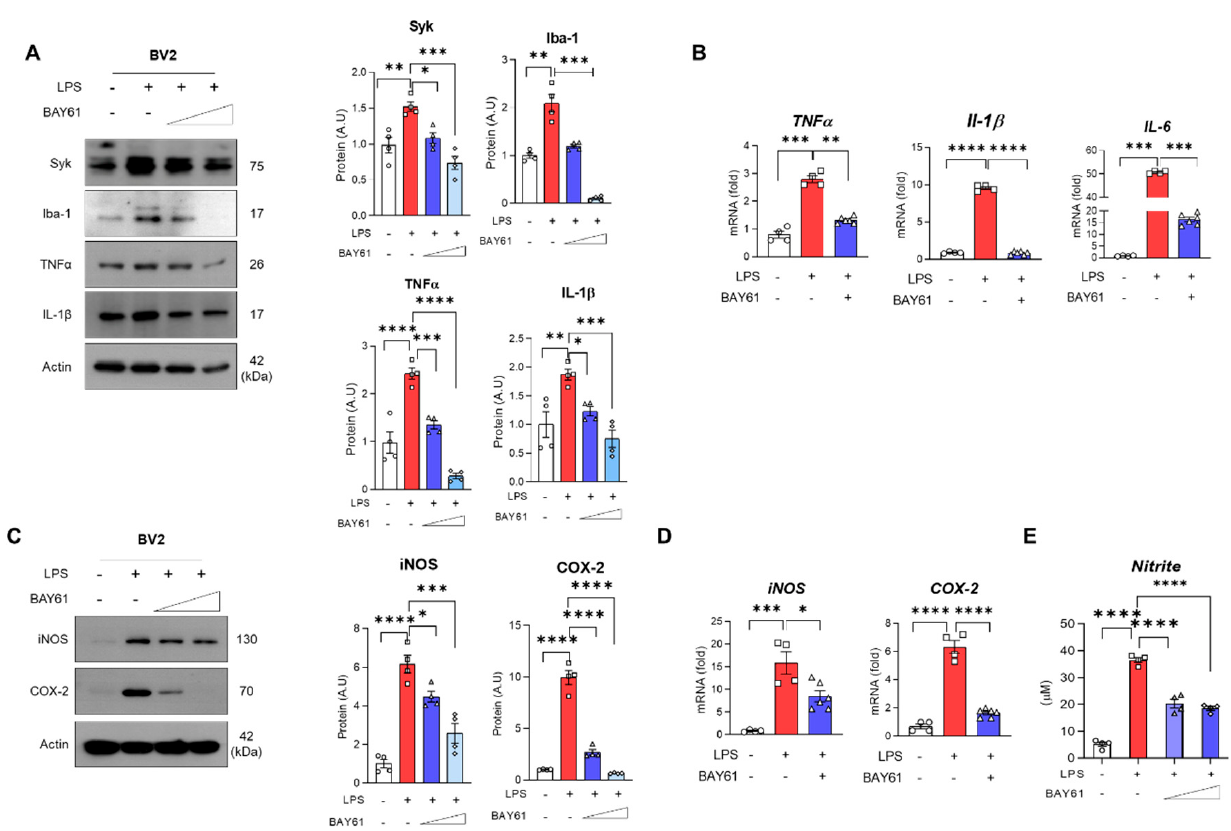
Figure 4. Pharmacological inhibition of Syk mitigates LPS-induced inflammation in BV2 microglial cells. ( A ) Western blot results of BV2 cells exposed to LPS (100 ng/mL) and BAY61-3606 (10 nM or 100 nM) for 24 h with respective graphs of Syk, Iba-1, TNF α , and IL-1 β ( n = 4). ( B ) Quantitative analysis of mRNA expressions of inflammatory cytokines; TNF α , Il-1 β , and IL-6 (CTL, n = 4; LPS, n = 4; LPS+BAY61-3606, n = 6). After treating LPS (100 ng/mL) and BAY61-3606 (10 nM or 100 nM) for 24 h, Media and cell lysates were separately collected. ( C ) Immunoblot and quantification of iNOS and COX-2 ( D ) mRNA of iNOS and COX-2 were measured by qPCR after treating LPS (100 ng/mL) and BAY61-3606 (100 nM) for 6 h (CTL, n = 4; LPS, n = 4; LPS+BAY61-3606, n = 6). ( E ) Nitrite concen- tration was determined in the media using Griess reagent. ( n = 4). Bar graph color, white: control, grey: control with BAY61-3606, red: LPS, blue: LPS with BAY61-3606. Values indicate the mean ± SEM. The significant differences have been given in the graphs as follows: * p < 0.05, ** p < 0.005,